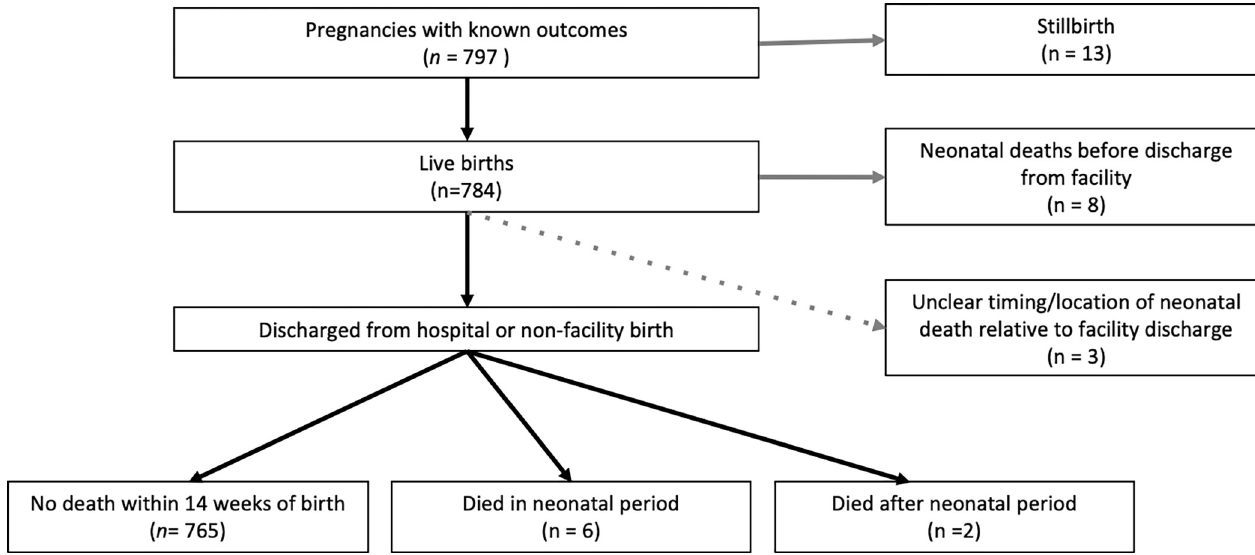
Fig 2. Flowchart of pregnancy and neonatal outcomes during the period of study. Neonatal deaths included deaths to 28 days of age (n = 17, neonatal mortality rate of 22 per 1000). Stillbirths (n = 13) occurred for a rate of 16 per 1,000 pregnancies.